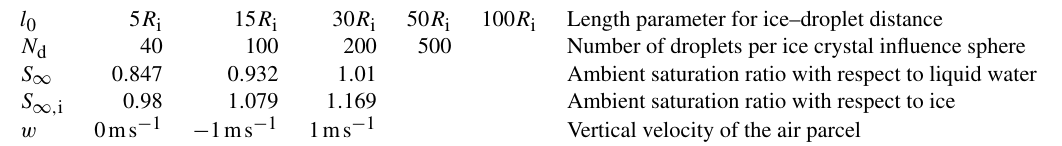
Table 1. Different parameter values used for the air parcel simulations. The initial ice crystal radius is R i = 100µm for every simulation.